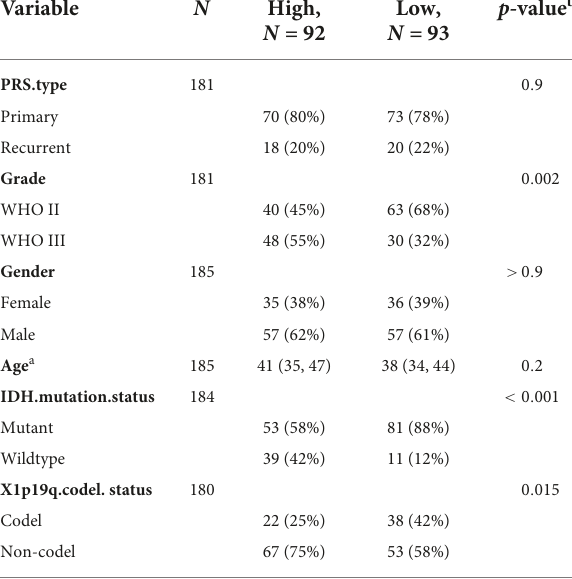
TABLE 2 The association with TFRC and clinicopathological characteristics in CGGA-LGG